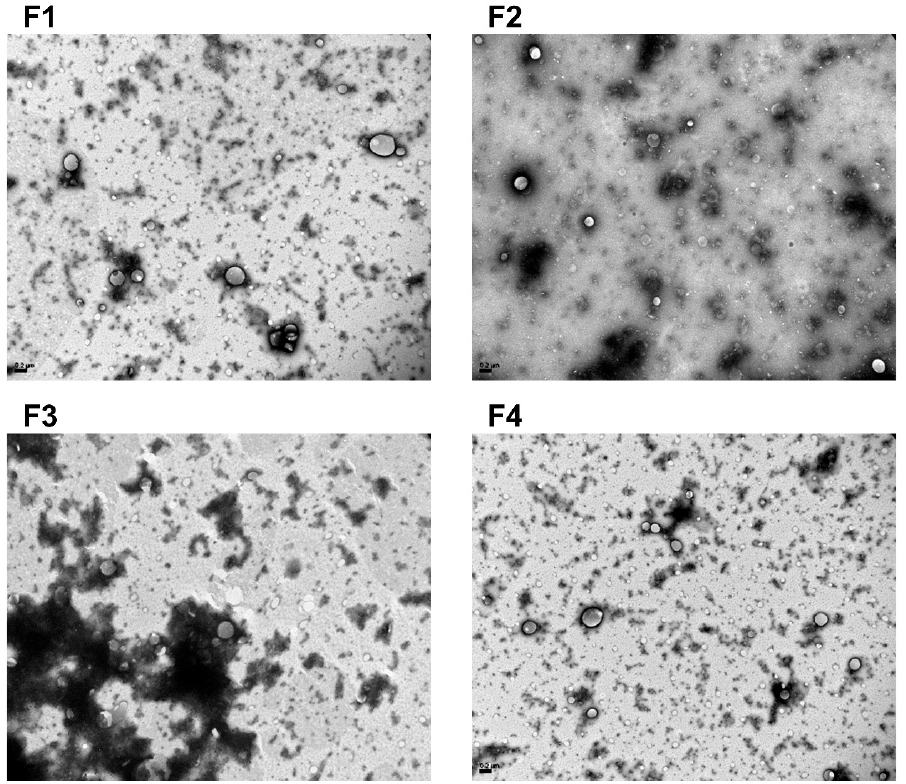
Figure 1. TEM images of NLCs (F1 to F4 formulations). The freshly prepared formulations (20 mg MM lipid/mL) were diluted with Milli-Q water (1:10) and the contrast was enhanced with phospho-tungstic acid. All images were taken at 30,000× (scale bar = 200 nm).